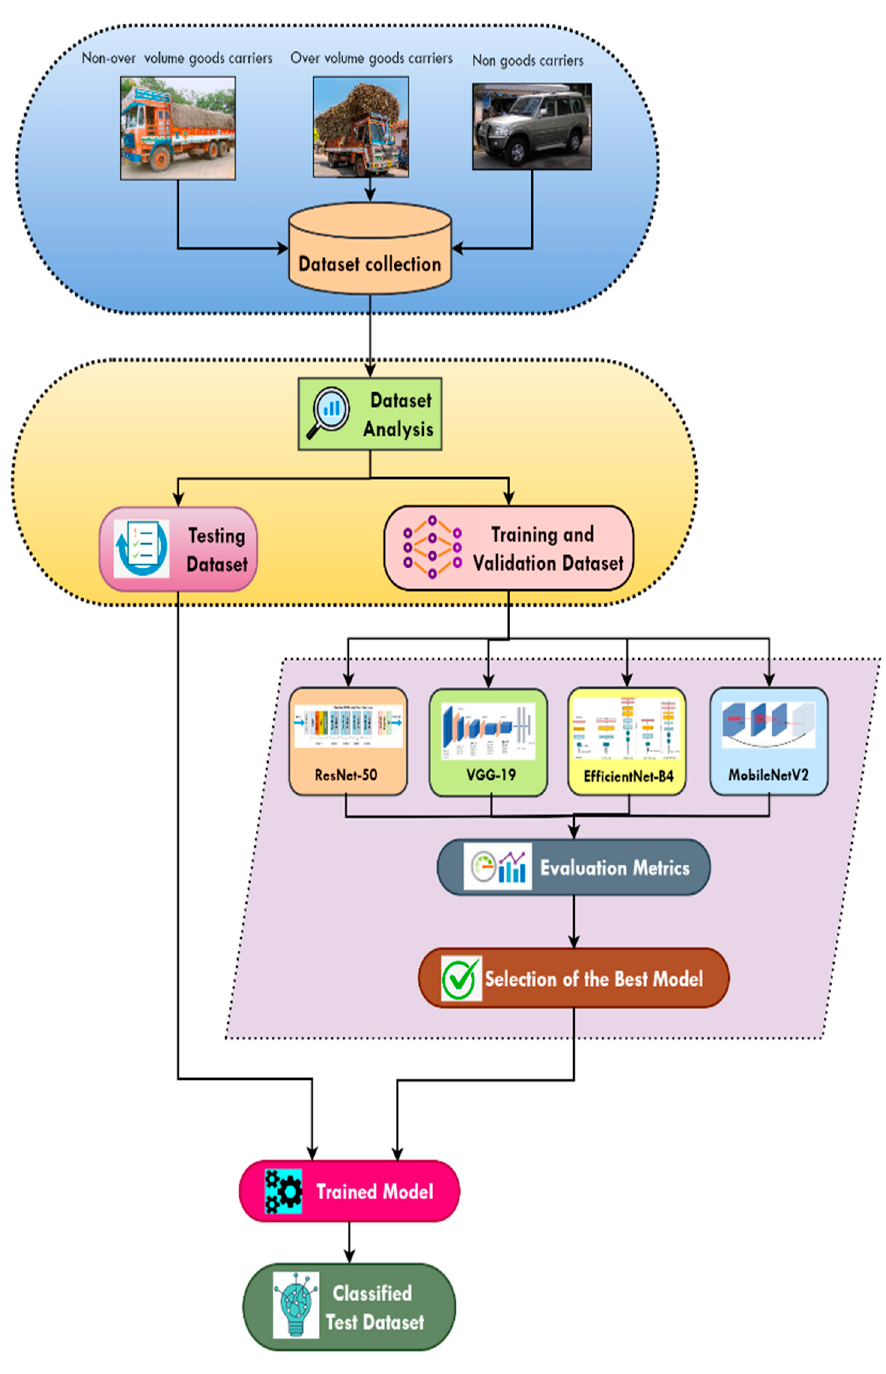
Figure 1. Proposed architecture.